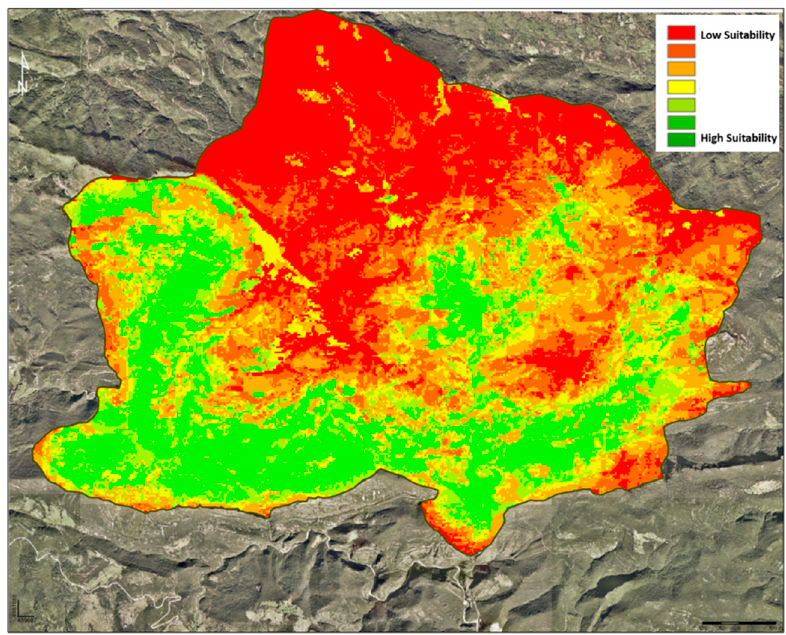
Figure 3. Suitability map according to the neutral weight. Source: (Varga, D. et al., 2018).